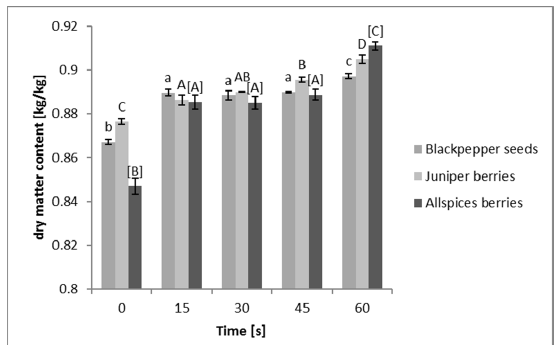
Figure 3. Dry matter content changes after plasma treatment. The significant di ff erences between investigated samples, based on the Tukey test results, are indicated by di ff erent small letters (a, b, c ... ), capital letters (A, B, C ... ) or capital letters in brackets ([A], [B], [C] ... ) for di ff erent spice species (black pepper seeds, juniper berries and allspices berries, respectively). n =